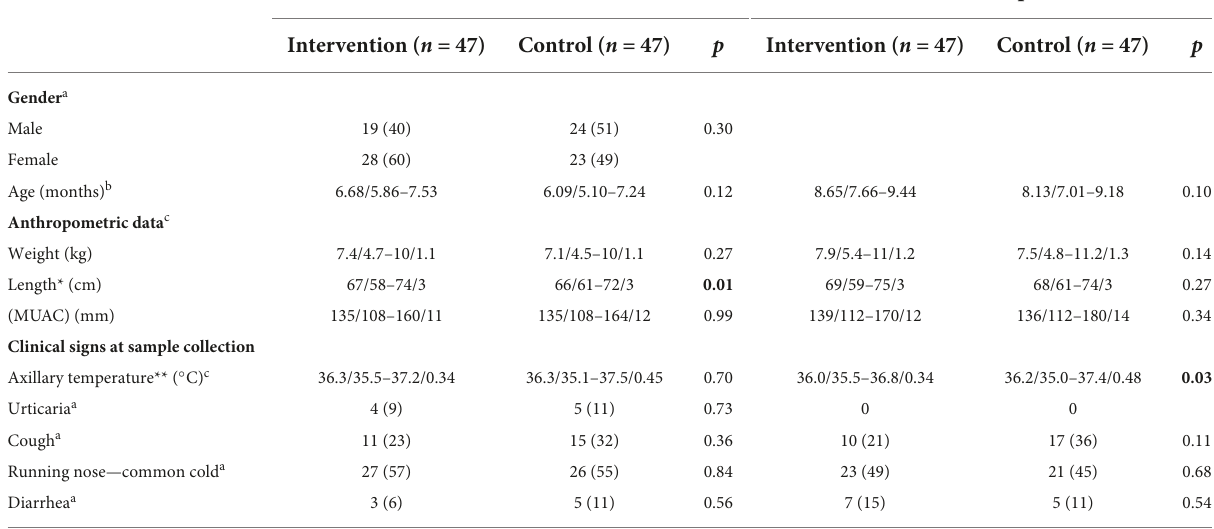
TABLE 1 Participant profiles at the enrollment and follow-up.